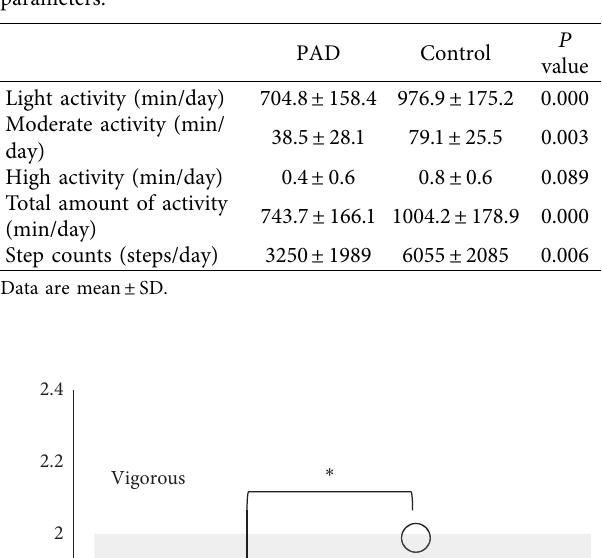
Figure 2: Box and whisker plots (median, quartile, and range) of time spent at activities of light-, moderate-, and high-intensity in PAD patients (left) and healthy control subjects (right). ∗ P < 0 . 001 between PAD and CON at light- and moderate-intensity activities. PAD, peripheral artery disease patients; CON, healthy control